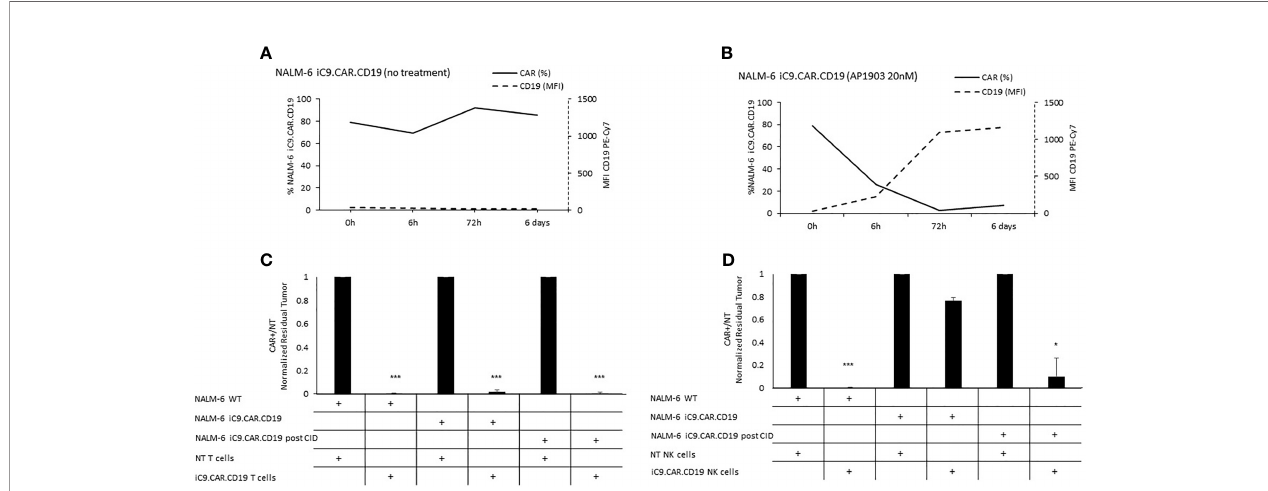
FIGURE 2 | Long-term in vitro assays to evaluate the activity of iC9 controlling CAR.CD19-positive leukemia cell lines. (A, B) iC9.CAR.CD19 NALM-6 cells were treated with 0 nM (A) and 20 nM (B) of AP1903; both CAR and CD19 expressions were monitored over time by fl ow cytometry. (C) A 7-day co-culture assay was carried out between un-transduced T cells or iC9.CAR.CD19 T cells and WT NALM-6 cells, iC9.CAR.CD19 NALM-6 cells never exposed to AP1903, and iC9.CAR.CD19 NALM-6 residual after AP1903 exposure and further re-expanded (at effector/target ratio of 1:1). (D) A 7-day co-culture assay was carried out using un-transduced NK cells or iC9.CAR.CD19 NK cells and WT NALM-6 cells, iC9.CAR.CD19 NALM-6 cells never exposed to AP1903, and iC9.CAR.CD19 NALM-6 residual after AP1903 exposure and further re-expanded (at effector/target ratio of 1:1) *p-value ≤ 0.05, ***p-value ≤